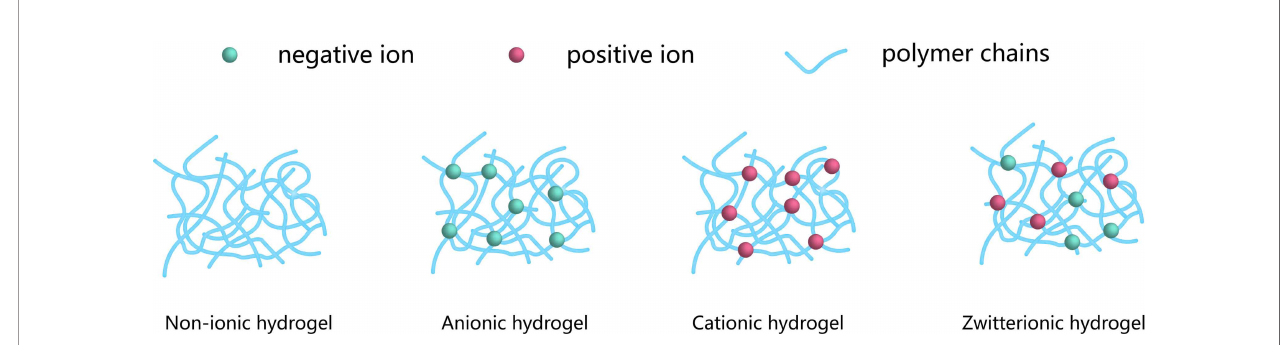
FIGURE 5 | Classi fi cation of the encapsulation, according to the network electrical charge. Hydrogels may be categorized into three groups: Nonionic, Ionic (including anionic or cationic) and Zwitterionic. The blue networks are hydrogel polymers, the green spheres are negative ions, and the red spheres are positive